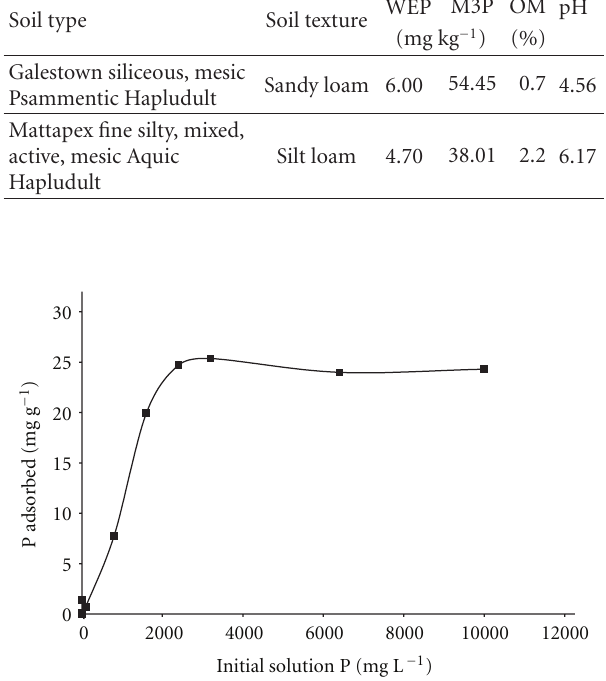
Figure 1: Cumulative phosphorus (P) sorption curve generated by summing four sequential